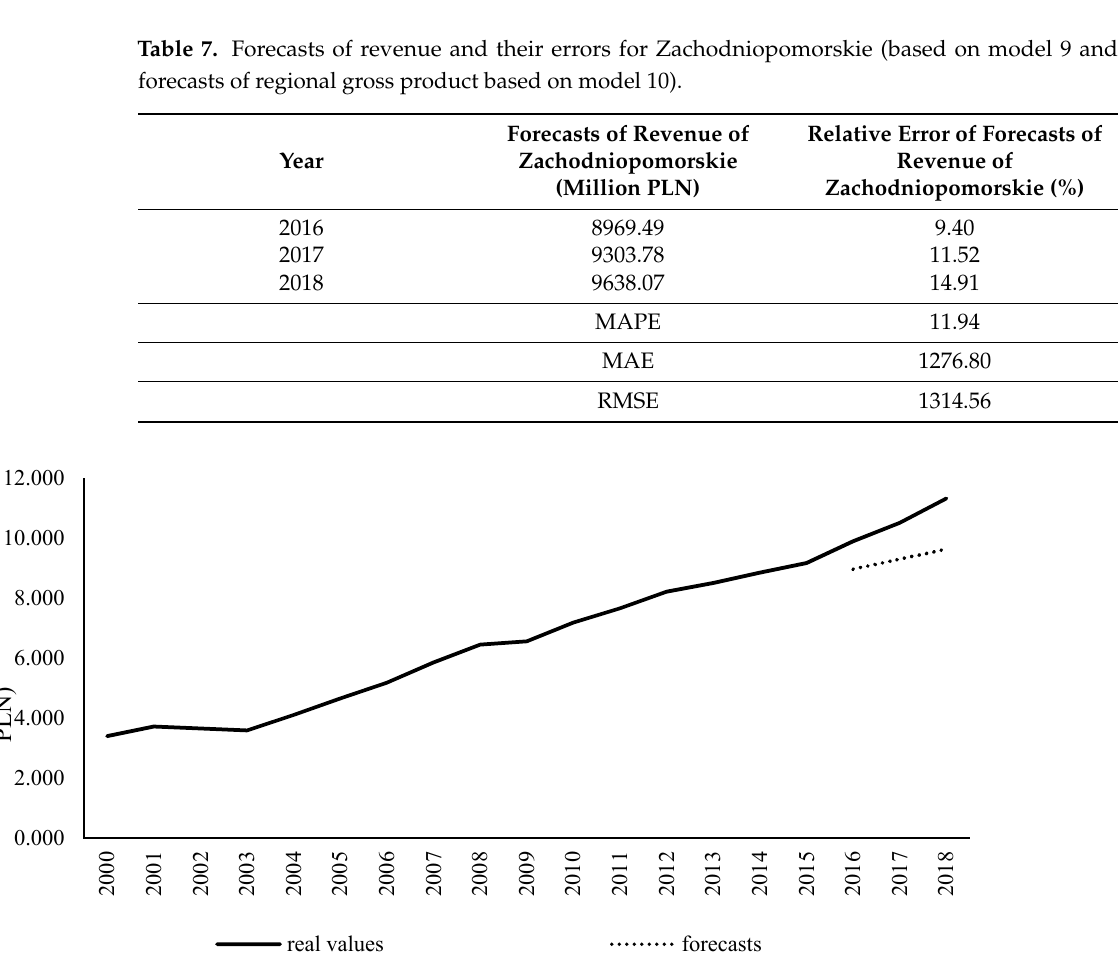
Figure 4. Real values (2000–2018) and forecasts (2016–2018) of revenue of Zachodniopomorskie voivodeship (based on model 9 and forecasts of regional gross product based on model 10).